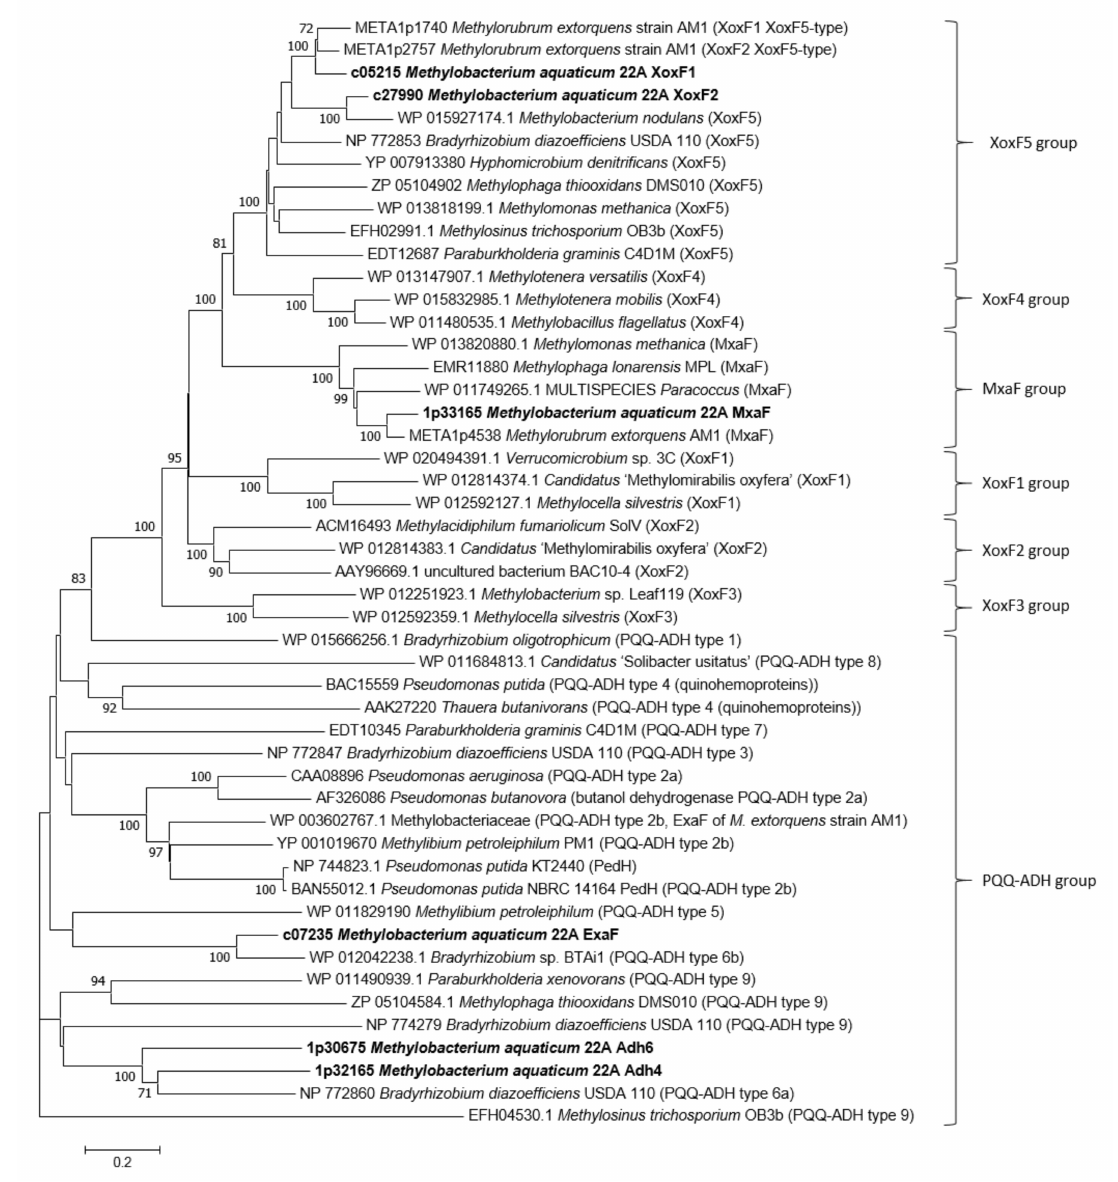
Figure 2. Molecular phylogenetic analysis of MDH-like proteins found in strain 22A (in boldface) and other related sequences. The evolutionary history was inferred by using the maximum likelihood method based on the Jones-Taylor-Thornton (JTT) matrix-based model [48]. The tree is drawn to scale. Evolutionary analyses were conducted in MEGA7 [49]. Bar, average number of amino acid substitutions per